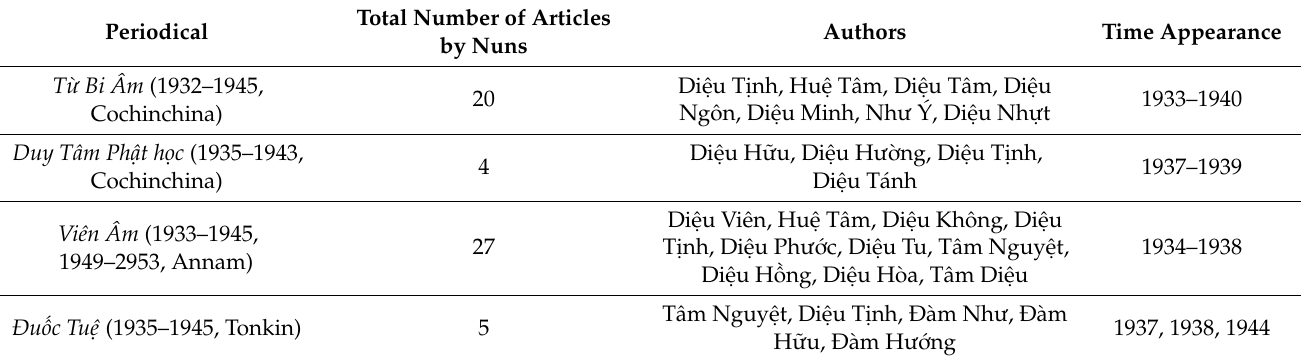
Table 2. A list of articles by nuns in the main Buddhism